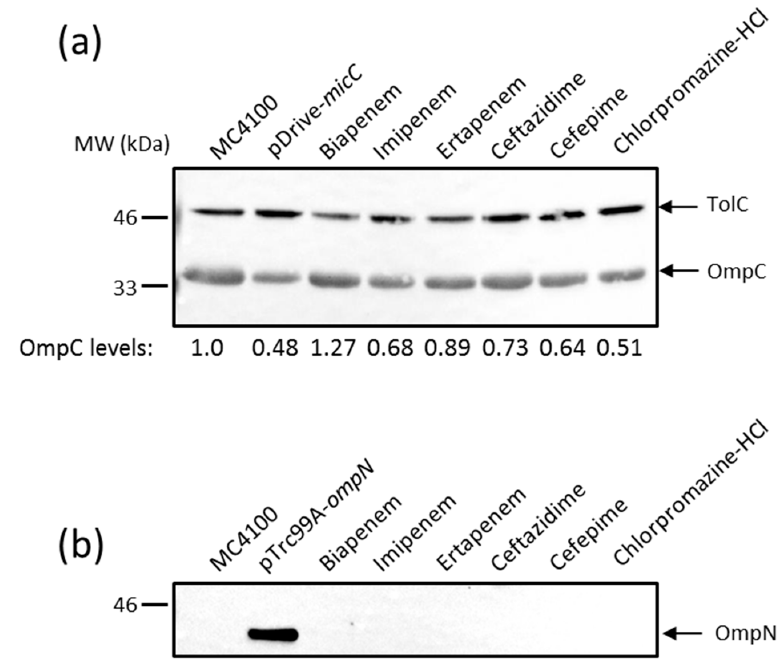
Figure 2. Western blot (WB) analysis of outer membrane (OM) proteins. Cells were grown, and OM extracts were prepared as described in the Materials and Methods. OM proteins equivalent to 0.2 OD 600 units of cultures were separated by SDS-PAGE, electrotransferred on nitrocellulose membranes, and blotted with the appropriate anti-sera. Data show the production of OmpC ( a ) and OmpN ( b ). Both the positive controls pDrive- micC and pTrc99A- ompN were induced by 0.4 mM IPTG for 3 h. TolC expression was used for normalizing sample loading, and the expression of normalized OmpC has been expressed in mean values from three independent experiments.